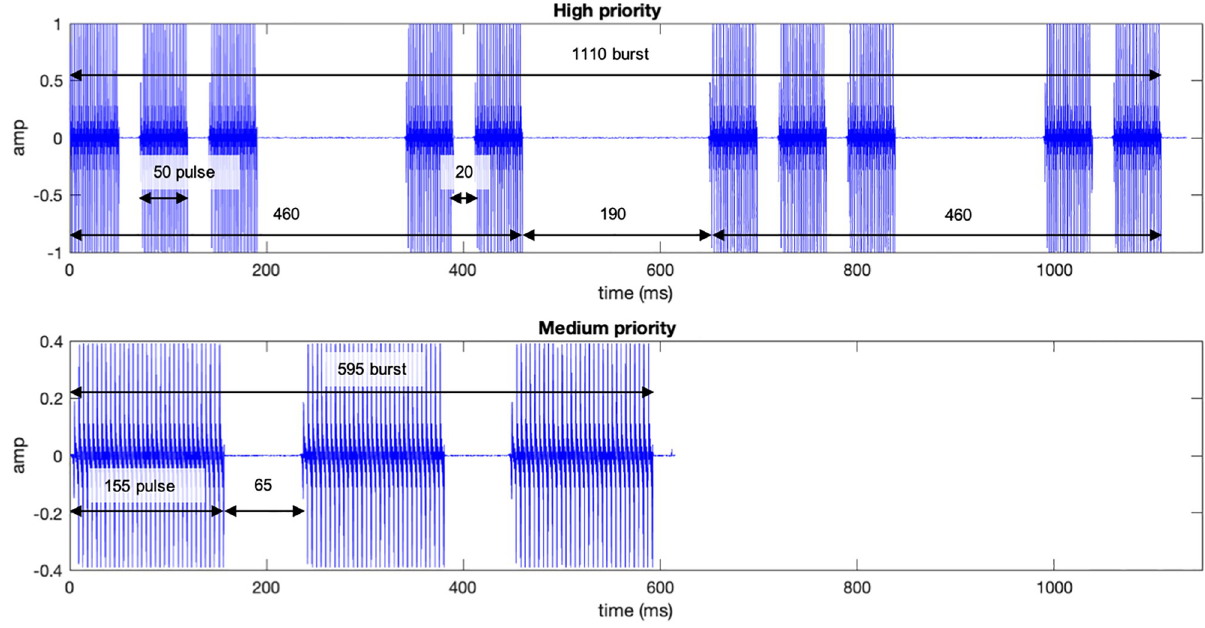
Fig 2. The HP pointer burst is composed of two identical five-pulse blocks separated by 190 ms, totaling 1110 ms of duration. HP pulses of 50 ms duration are repeated in the schematized rhythm pattern (top). The MP pointer burst has a total duration of 595 ms. MP pulses of 155 ms duration are repeated in the schematized rhythm pattern. The HP burst has a faster and uneven rhythm, features that are associated with a higher urgency perception.